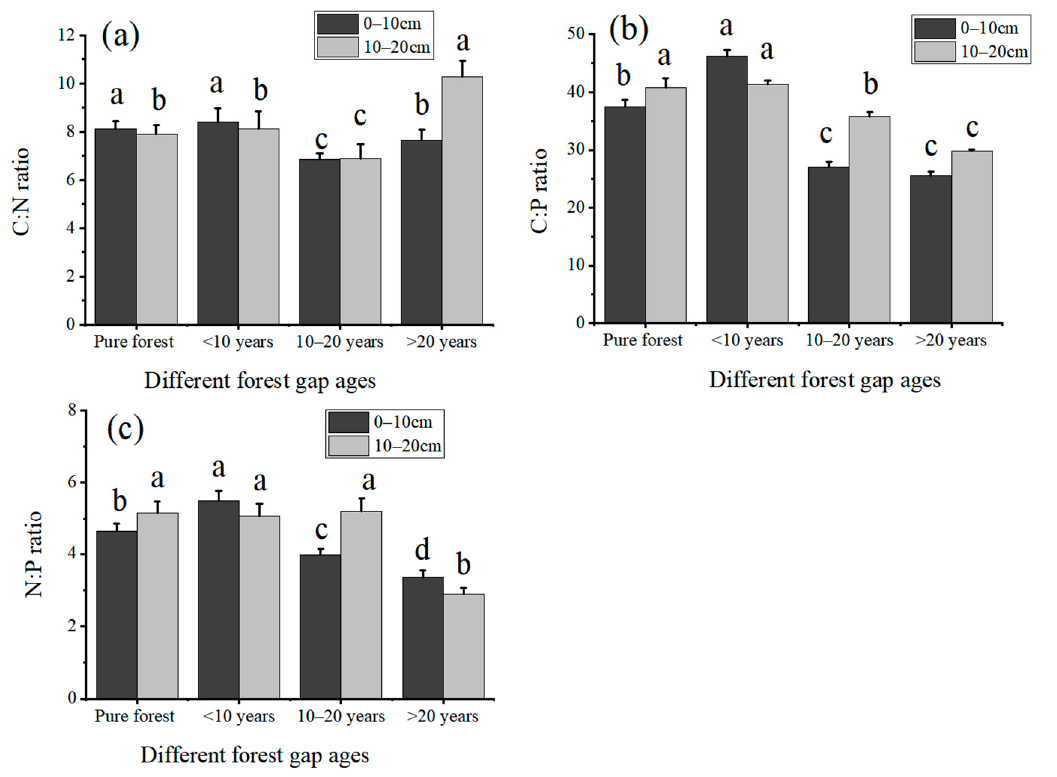
Figure 3. Variations of C:N ratio ( a ), C:P ratio ( b ), and N:P ratio ( c ) in different forest gap ages. Note: Different letters indicate significant differences between different forest gap ages in the same soil layer ( p < 0.05). Error bars represent ±standard errors.